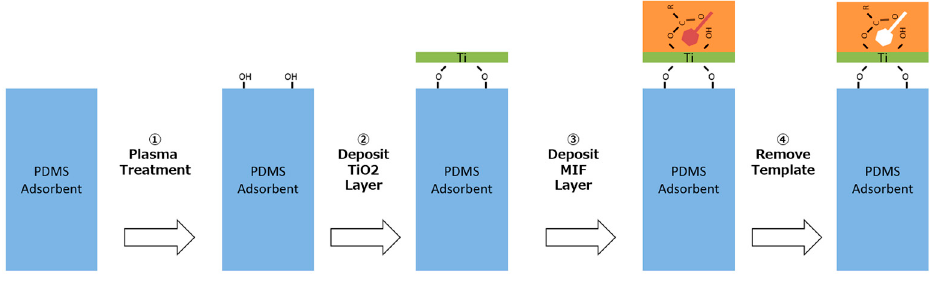
Figure 3. Procedure for MIFA fabrication.